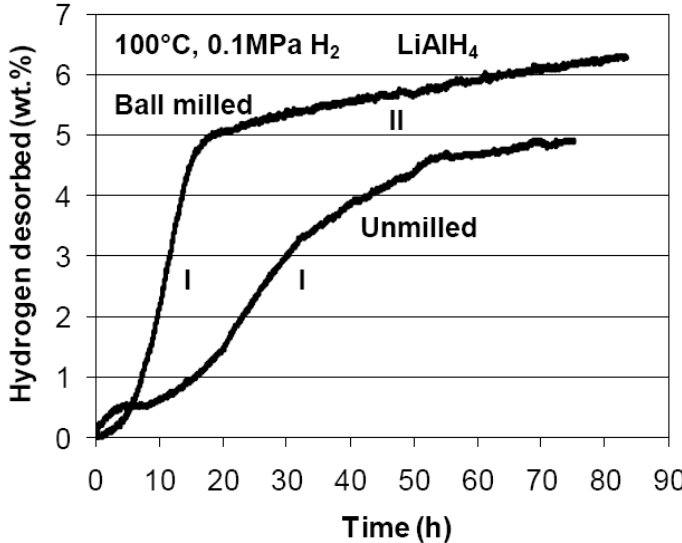
Figure 5. Comparison of volumetric desorption curves at 100 °C under 0.1 MPa H pressure for unmilled (as-received) LiAlH energy. Adapted from